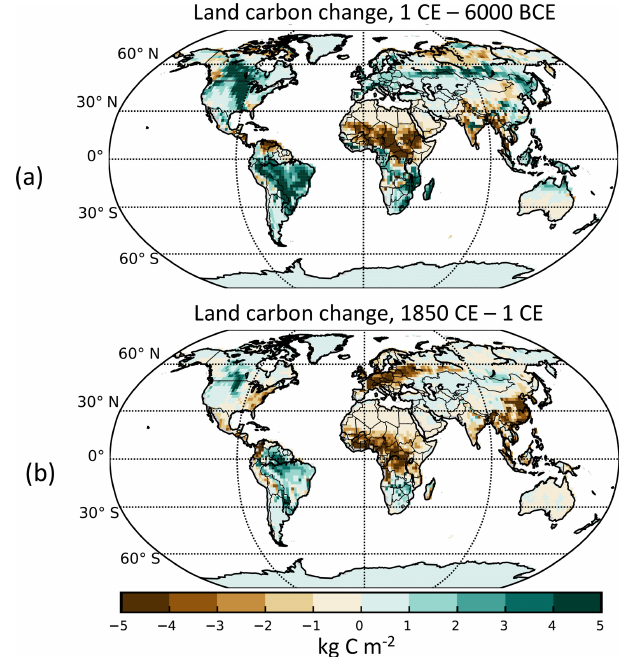
Figure 6. Change in land carbon density (kgCm − 2 ), relative to 6000BCE at 1CE (a) and at 1850CE relative to 1CE (b) in the TRAFc simulation.